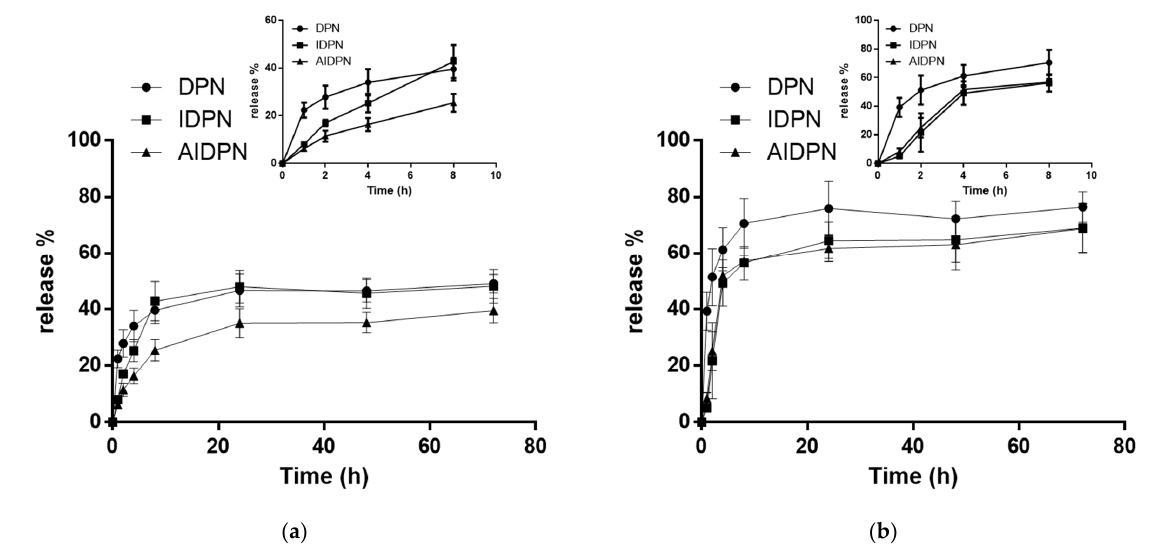
Figure 4. The release profile of DPN, IDPN, and AIDPN in ( a ) pH 7.4 PBS and ( b ) pH 5.5 PBS at 37 °C within 3 days. Inserted graphs show the release profile of DPN, IDPN, and AIDPN within 8 h in pH 7.4 PBS and pH 5.5 PBS. (n = 3; mean ± standard deviation).